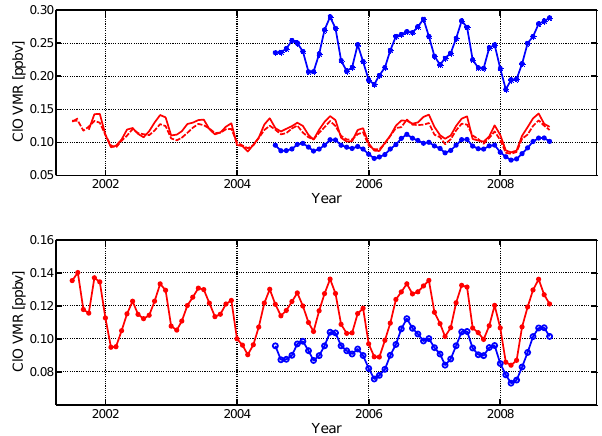
Fig. 8. Scaled SMR and MLS ClO observations as a function of time for 35–45km and 20 ◦ S–20 ◦ N. Top, AM and PM scaled monthly averages; MLS AM blue star, MLS PM blue dot, SMR dawn red solid line, SMR dusk red dash line. Bottom, SMR (red) scaled combined AM and PM profiles, and MLS scaled (blue) day profiles.